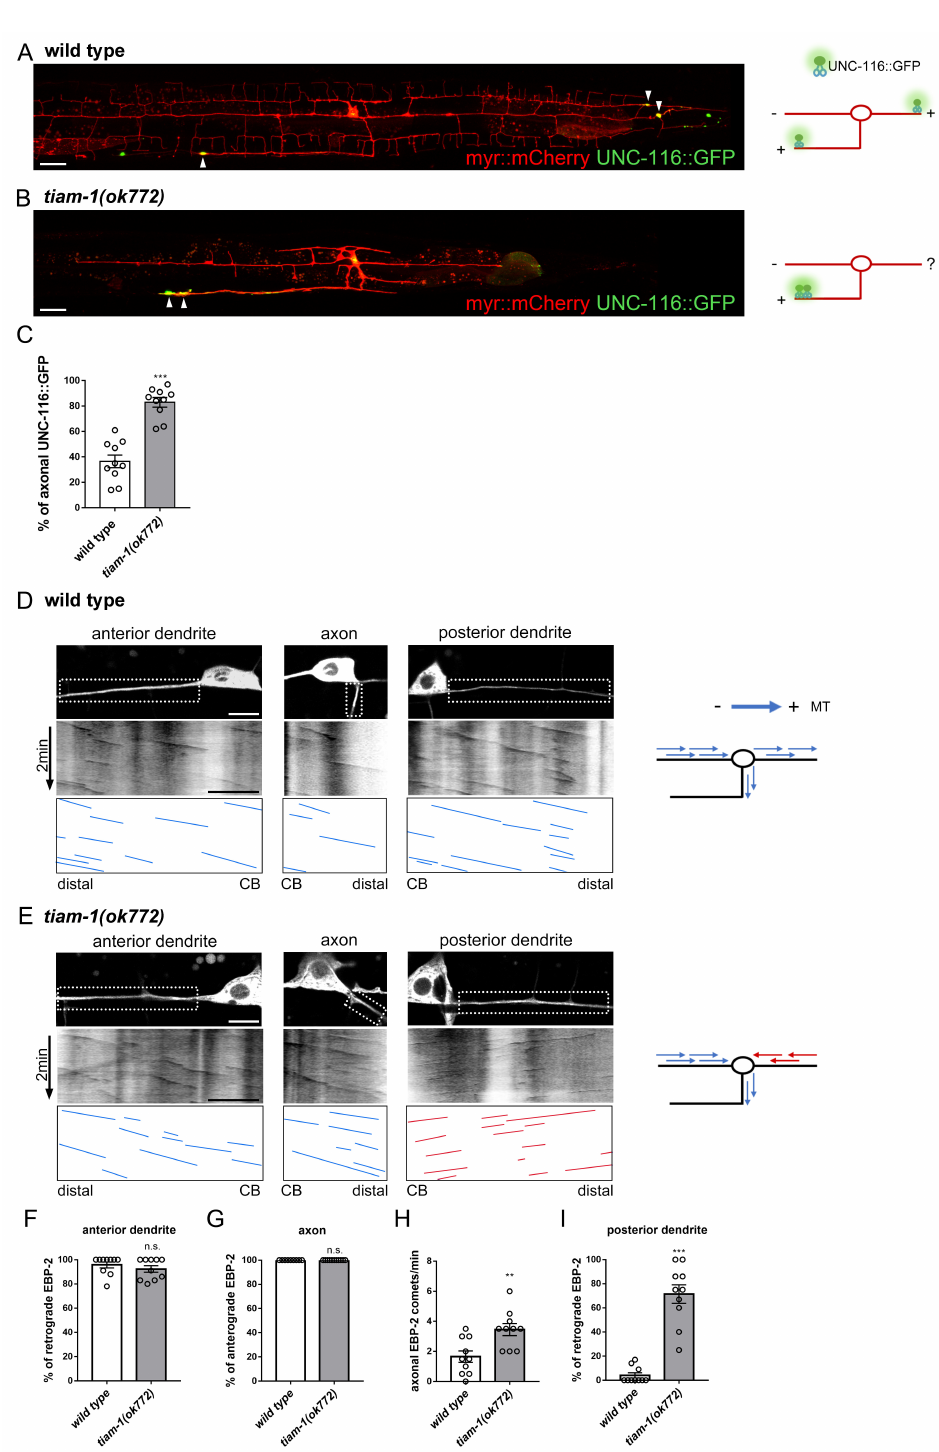
Fig 3. TIAM-1 is required for developing the organized microtubules in PVD neuron. (A and B) PVD neurons expressing UNC-116::GFP and myr::mCherry ( ntuIs2 ) of wild type (A) and tiam-1(ok772) (B), with schematic diagrams of phenotypes. Arrowheads indicate UNC-116::GFP signal. Scale bar, 20 μ m. (C) Quantification of axonal UNC-116::GFP intensity. Student’s t -test. Error bar represents SEM. n = 10. n.s., not significant, ��� P < 0.001, compared to wild type. (D and E) Top: PVD neurons expressing the microtubule plus-end marker EBP-2::GFP ( hrtSi5 ) of wild type (D) and tiam-1(ok772) (E). Bottom: The corresponding kymographs. Right: schematic